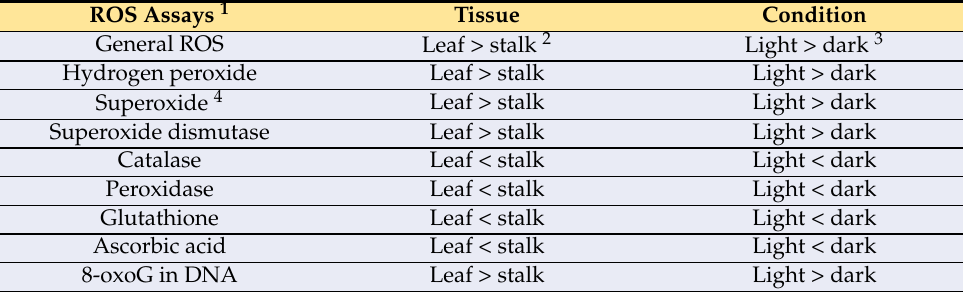
Table 1. Summary of ROS and glycation assays in